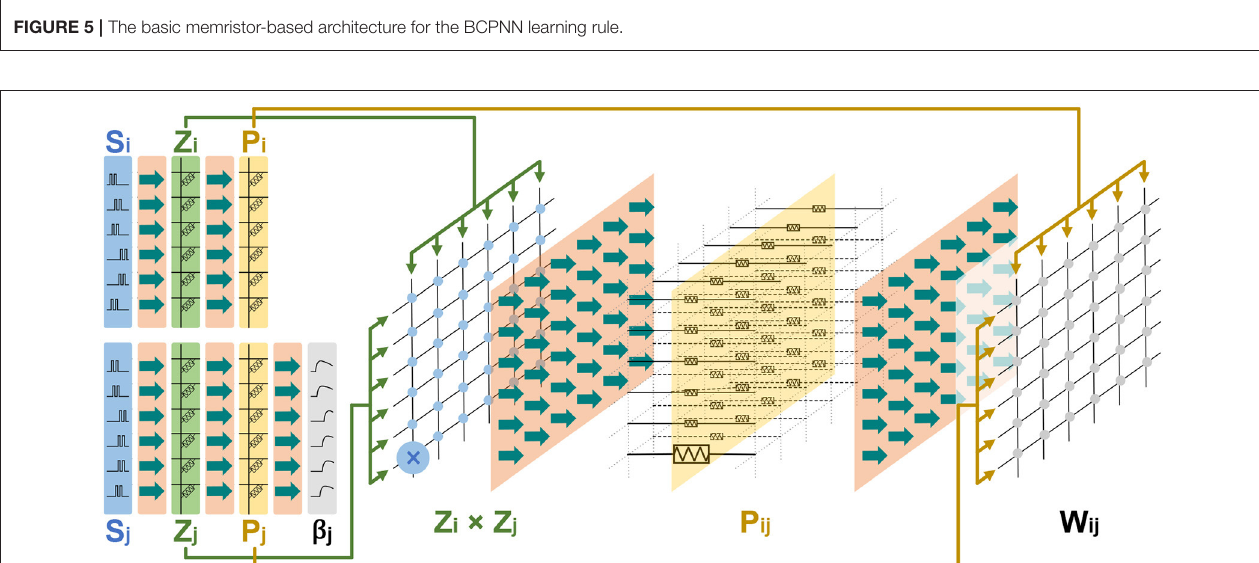
FIGURE 6 | The memristor-based architecture for an HCU with a configuration of 6 × 6.